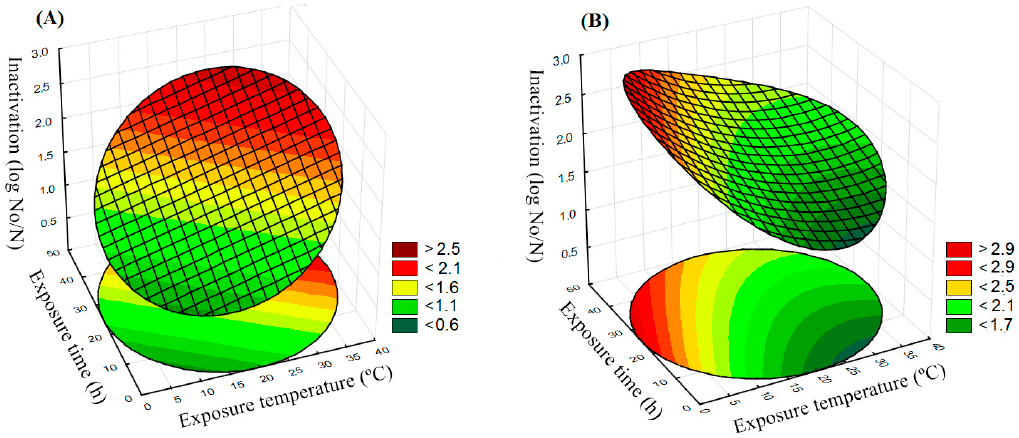
Figure 1. Salmonella Typhimurium inactivation response surface (Log (N 0 /N)) in: ( A ) Brazilian dry-cured loin(BDL) under different exposure temperatures and periods in the dry-cured matrix; ( B ) One-hour simulated gastric fluid (SGF) — at pH 1.5 following exposure under different temperatures and times in the BDL matrix.